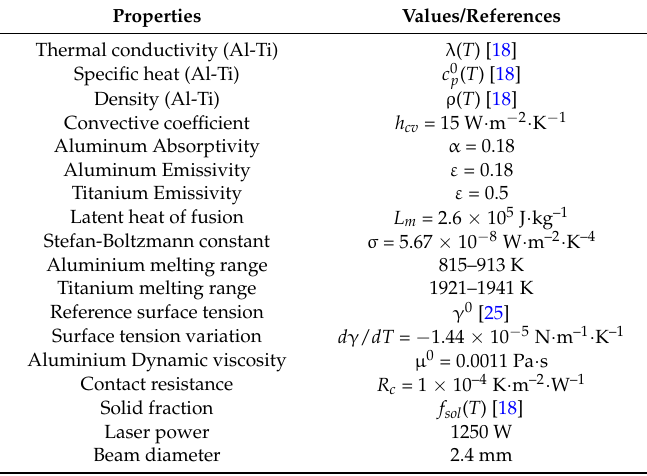
Table 1. Materials’ properties.